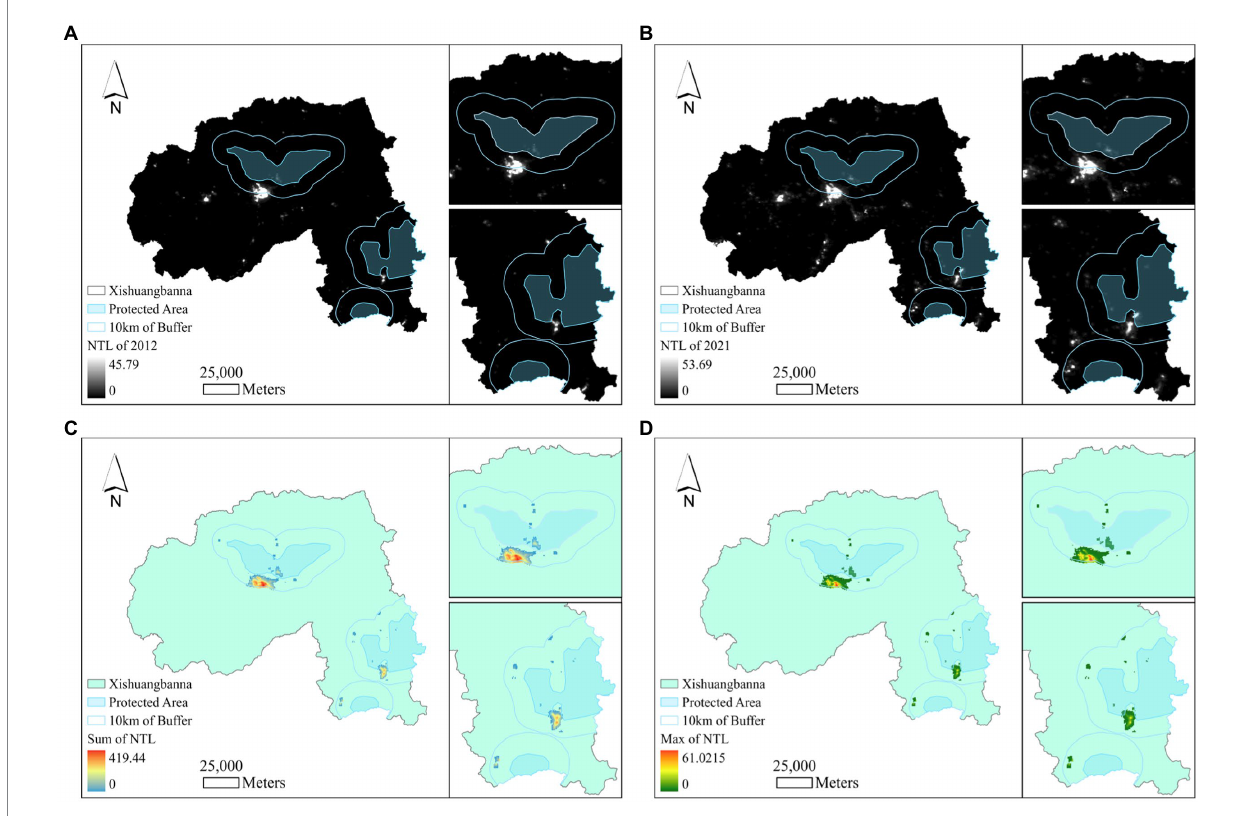
FIGURE 3 2012–2021 NTl spatial distribution: (A,B) are the NTL images of Xishuangbanna region in 2012 and 2021, respectively, and (C,D) are the total and maximum NTLs of PAB region on the image metric scale from 2012 to 2021,